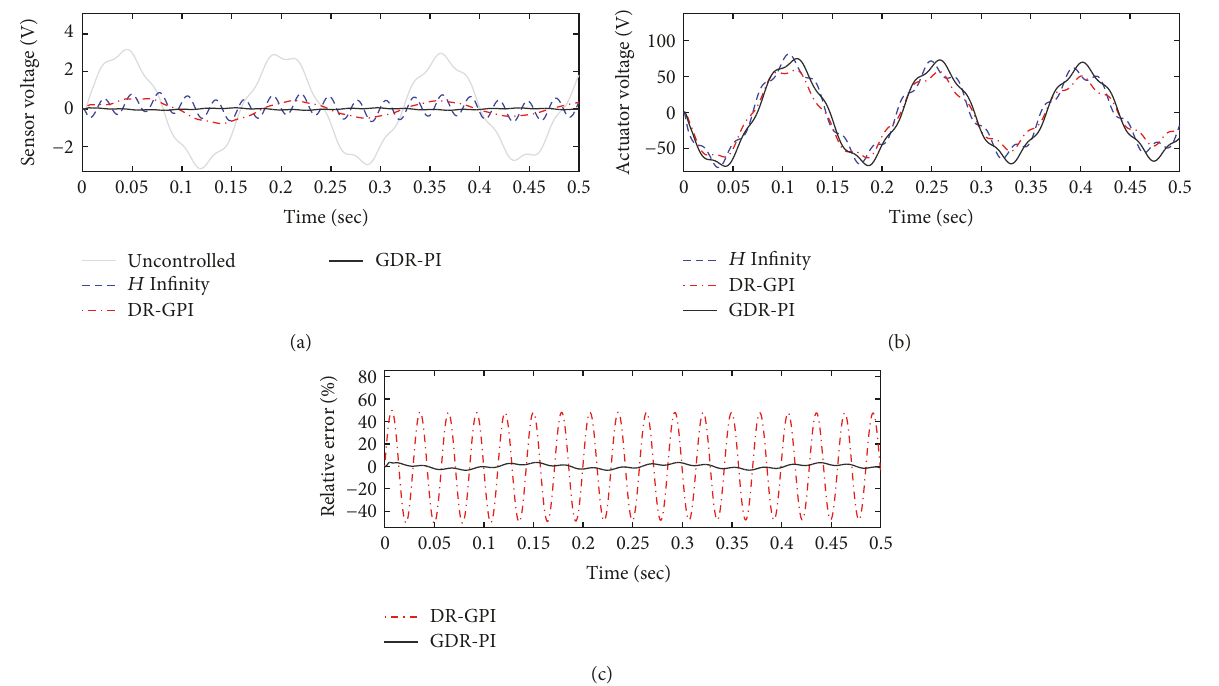
Figure 6: The time domain response of the controlled and uncontrolled smart beam under a harmonic disturbance with unknown influence matrix and the second eigenfrequency: (a) sensor output, (b) control input, and (c) relative error of estimated